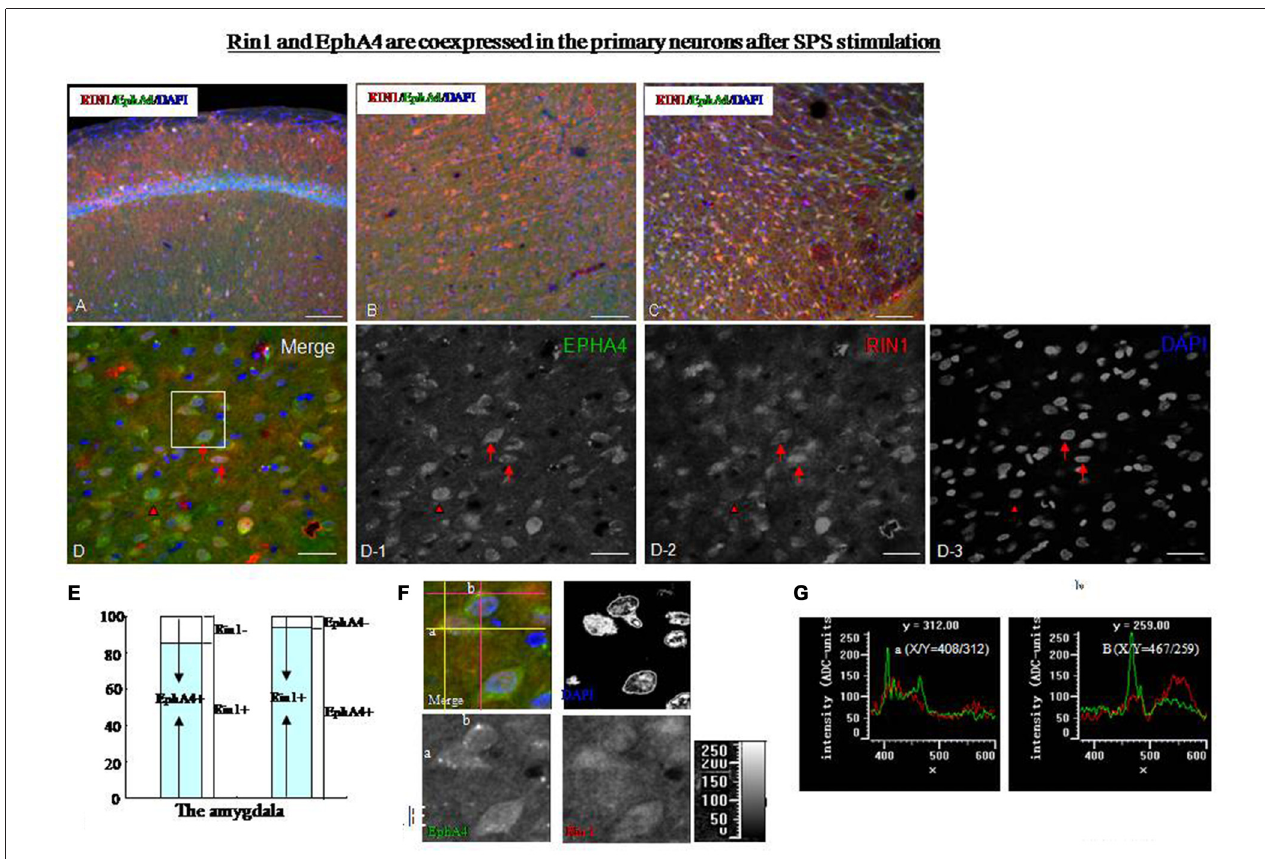
FIGURE 7 | (A–C) Dual-immunofluorescence images showing that Rin1-ir and EphA4-ir were colocalized in the hippocampus (A) , cingulate cortex (B) , and thalamus (C) of SPS rats. (D) Higher magnification image of the amygdala shows colocalization of Rin1/EphA4 (arrow) and EphA4- or Rin1- positive cells (arrowhead). EPHA4: D-1 ; RIN1: D-2 ; DAPI: D-3 . (E) Statistical analysis indicated that about 88% of EphA4-positive cells were Rin1-positive, and 93% of Rin1-positive cells were EphA4-positive in the amygdala. (F) Higher magnification images of the area in the white box in panel (D) . Some bright clusters were detected (merge). Two clusters (a and b) were selected by positioning the coordinates (a: intersection of two yellow lines; b: intersection of two pink lines). (G) Intensity of points a and b. The green line shows the intensity of EphA4, and the red line shows the intensity of Rin1. EphA4 was expressed at peak intensity at points a ( X / Y = 408/312) and b ( X / Y = 467/259; ∗ P < 0.05 vs. the control group; Bar in A–C : 100 µ m; Bar in D : 20 µ